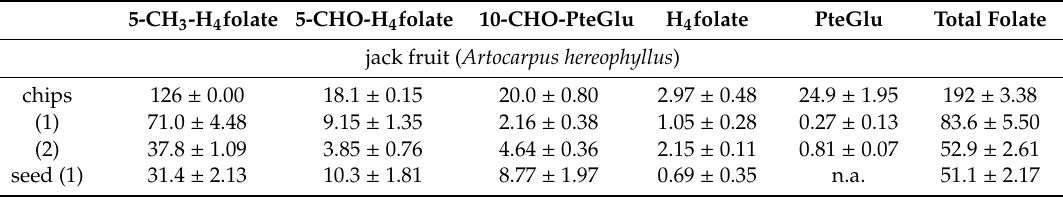
Table 4. Total folate content ( µ g / 100 g, calculated as PteGlu) in jack fruits, jack fruit seeds, and jack fruit